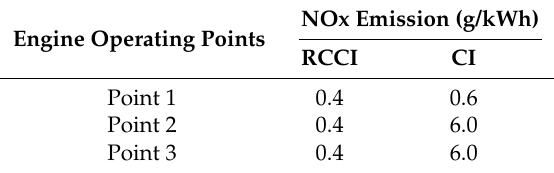
Table 3. Engine-out NO x emissions in RCCI and CI engines operating points. The data is from